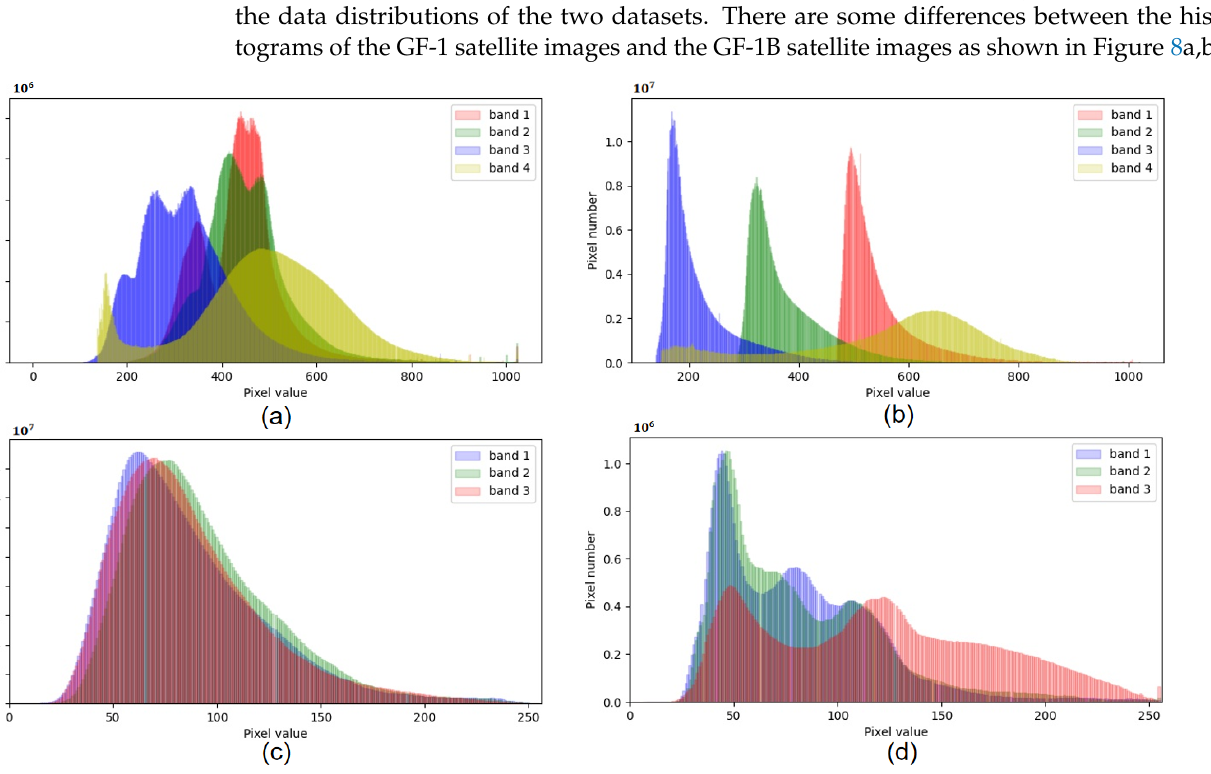
Figure 8. Color histograms of the Ganfen data set and the ISPRS data set. Different colors represent the histograms for different channels. ( a ) GF-1 images. ( b ) GF-1B images. ( c ) Potsdam images. ( d ) Vaihingen